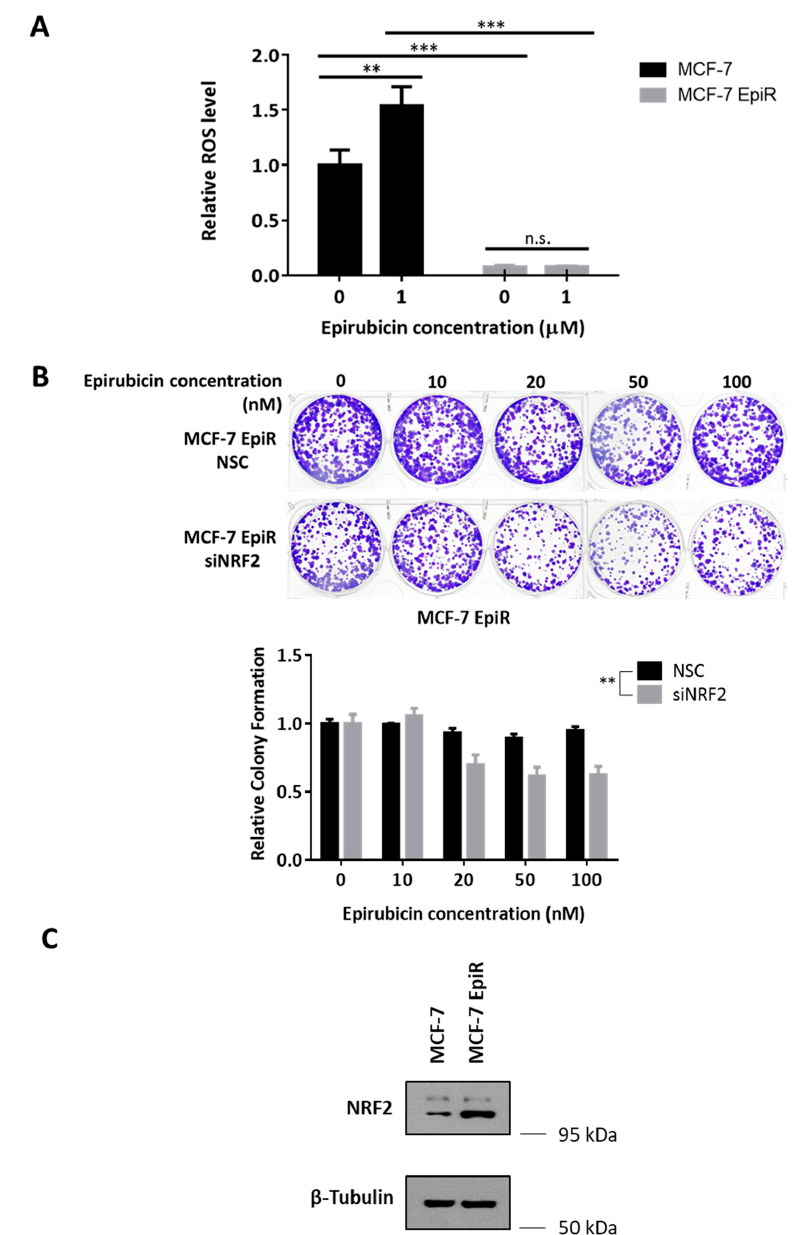
Figure 2. NRF2 modulates epirubicin resistance in breast cancer cells. ( A ) MCF-7 and MCF-7 EpiR cells were treated for 24 h with epirubicin at 1 µM. MCF-7 and MCF-7 EpiR cells were stained with CellROX Deep Red reagent and analyzed for ROS levels by flow cytometry. Data were analyzed by FlowJo software. The mean fluorescence values were presented as relative ROS level compared to untreated cells (0 µM). Data presented as mean ± SD. Student’s t -test was used to compare the means: ** p < 0.01; *** p < 0.001; n.s. nonsignificant. (N = 4) ( B ) Knockdown of NRF2 was achieved by transfecting 4 specific siRNA against NRF2 (siNRF2, 150pmol) to MCF-7 EpiR cells in a 6-well plate. Non-targeting siRNAs were used as control (NSC). At 24 h post-transfection, these cells were seeded in 6-well plates and treated with increasing doses of epirubicin for 14 days. Their sensitivity to epirubicin was assessed by clonogenic assay. Their clonogenicity in response to epirubicin was analyzed by two-way ANOVA and found to be significantly di ff erent (** p < 0.01) from one another. (N = 3) ( C ) Expression of NRF2 in MCF-7 cells and MCF-7 EpiR cells was detected by Western blot. β -Tubulin served as the loading control. (N =